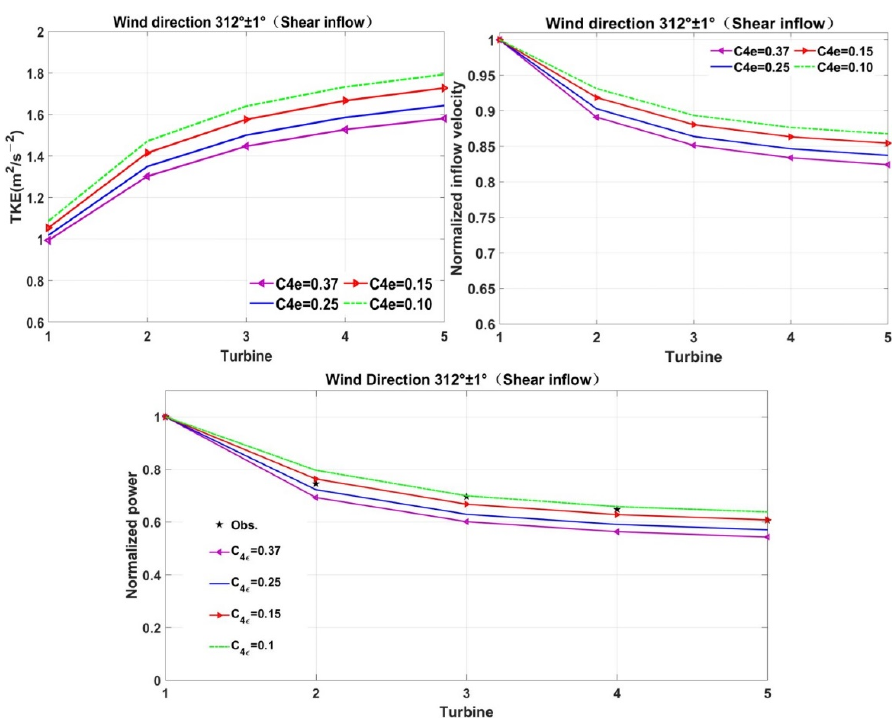
Figure 17. Effects of different C 4 ε values on TKE, inflow wind speed and power output under shear inflow conditions when the incoming wind direction is 312 ± 1°.